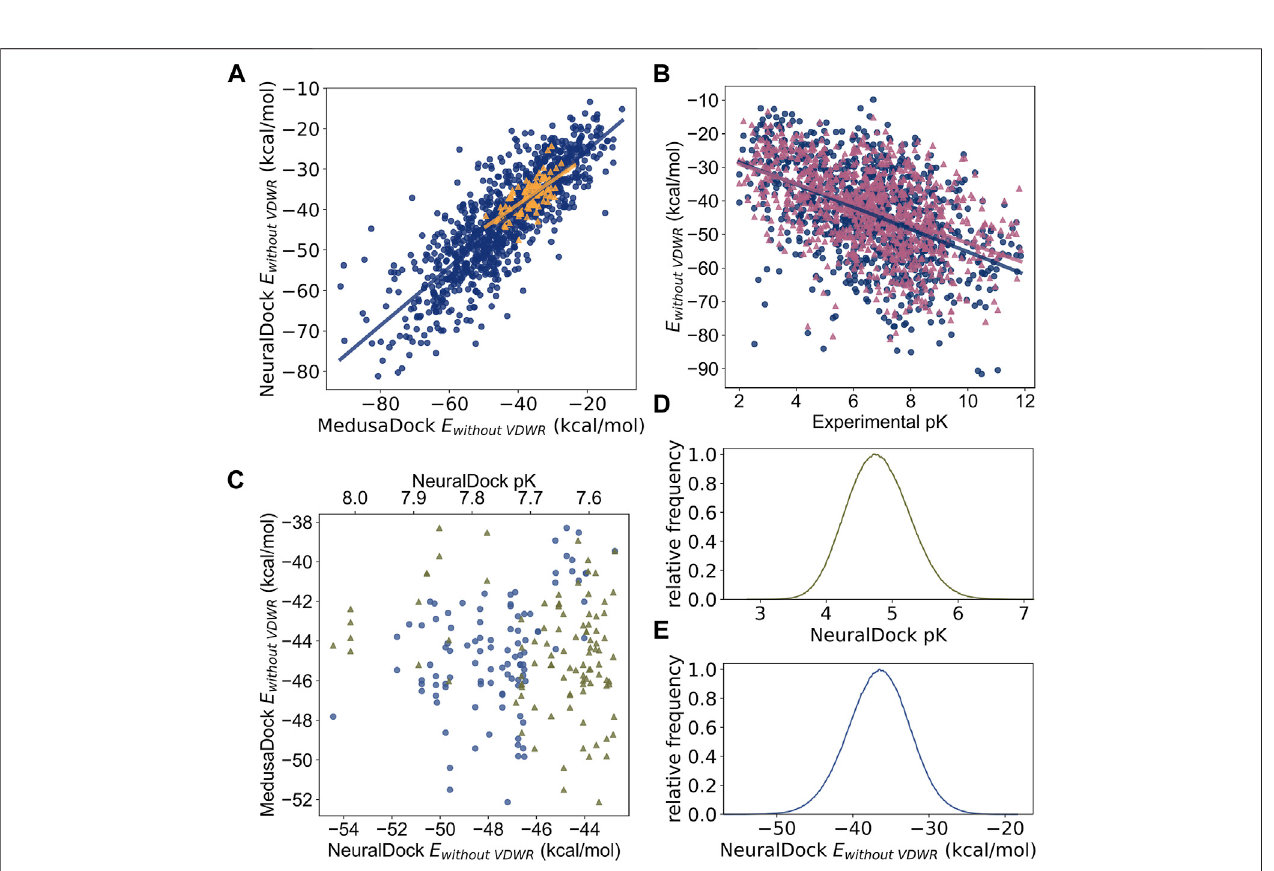
FIGURE 3 | Comparisons among MedusaDock energies, NeuralDock predicted energies, and experimental binding af fi nity data. (A) The correlation between NeuralDock predicted E without VDWR and MedusaDock E without VDWR on the validation set (blue circles, r = 0.83, p < 0.0001) and 100 random small molecules docked to 1UXM (orange triangles, r = 0.69, p < 0.0001). NeuralDock performs well on the validation set in predicting MedusaDock energies, and the trend generalizes to 1UXM with no signi fi cant difference (2-way ANCOVA F = 0.67, p = 0.41). (B) The correlations of MedusaDock E without VDWR (blue circles), NeuralDock predicted E without fi nity (pK) on the validation set ( r = − 0.48 for both data sets, p < 0.0001), with no signi fi cant difference (2-way VDWR (magenta triangles), and experimental binding af ANCOVAF=1.27, p =0.26). (C) The100smallmoleculeswithmaximumNeuralDockpK(green triangles), fromdocking of936,054,166small moleculesfrom theZINC libraryagainst1UXM;thecorrespondingpredictedE withoutVDWR isplotted(lilaccircles).Theleftishigherbindingaf fi nity(higherpK)andlowerenergy(lowerE withoutVDWR ). (D) and (E) The relative frequency distributions (300 bins) of NeuralDock predicted pK (mean 4.07, std 0.47) and E without VDWR (mean − 36.6, std 4.1), respectively, on 8,099,176(9%oftotal)randomlyselectedsmallmoleculesfromthedockingof1UXM.Theplotsarecenteredatthemeans,the x -axisrangesare±5standarddeviationsfrom the mean, and colors are repeated from (C) . Note that both the E without VDWR and pKs in (C) are drawn from the extreme tails of the distributions shown in (D)